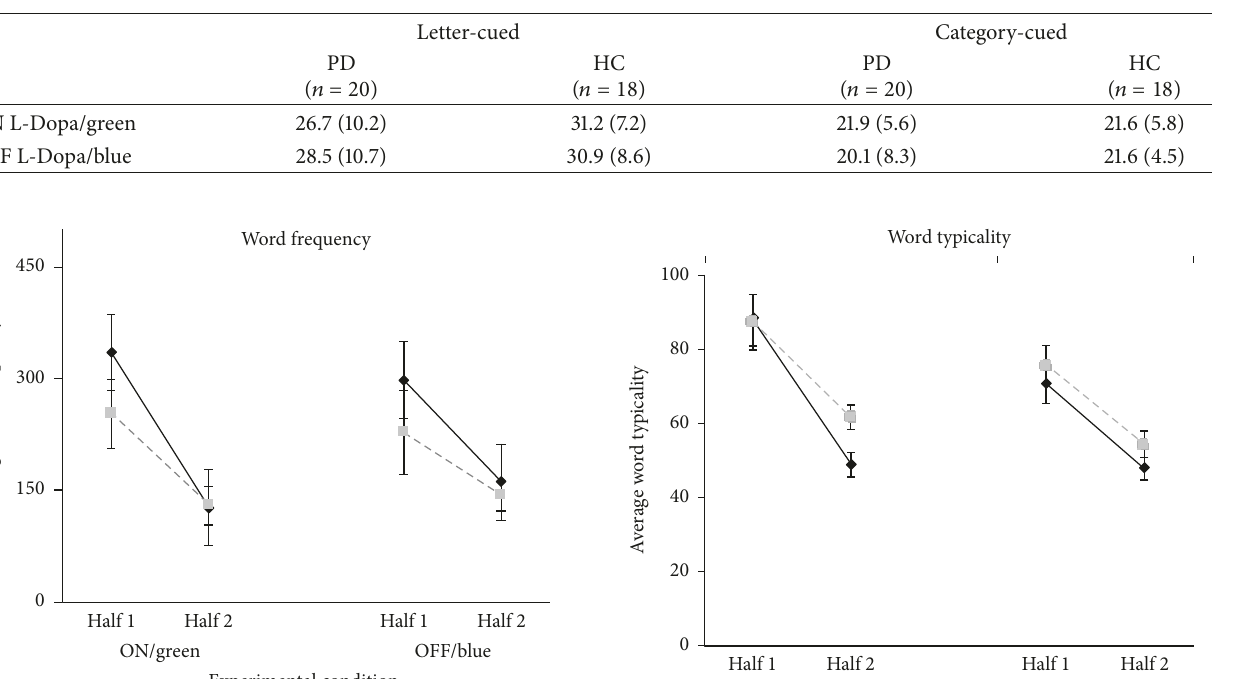
Table 2: Average (SD) number of words generated by PD patients and HC in the letter-cued and category-cued fluency tasks. Note that PD patients performed the tasks in two distinct pharmacological conditions (ON versus OFF L-Dopa treatment), whereas HC took no drugs prior to either task session.